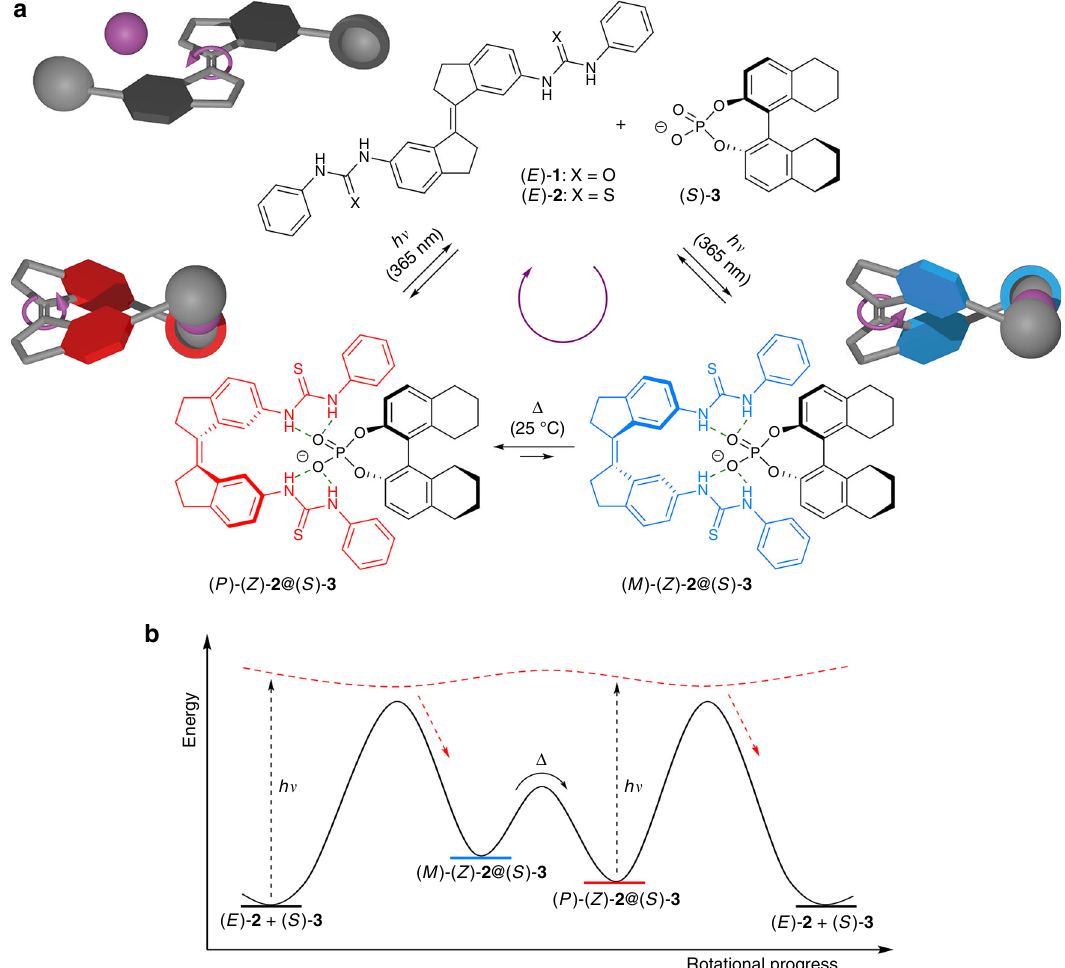
Fig. 1 Chiral substrate induced unidirectional rotation in a photoswitchable receptor. a Scheme of photochemical and thermal isomerization steps showing that when starting from the planar ( E )-isomer, e.g. bis-thiourea receptor ( E )- 2 , irradiation with light produces a racemic mixture of helical ( P )-( Z )- 2 and ( M )-( Z )- 2 . Binding of a chiral guest molecule to the receptor, e.g. phosphate ( S )- 3 favours formation of one of these helical ( Z )-isomers. As a consequence, the backward photochemical isomerisation process, affording the ( E )-isomer, takes place predominantly from the most favoured ( Z )-isomer, i.e. ( P )-( Z )- 2 @( S )- 3 resulting in a net unidirectional rotation. b Illustrative energy pro fi le describing a full rotation. Note that ( P )-( Z )- 2 and ( M )-( Z )- 2 are produced with equal probability and that only formation of the fi rst isomer gives rise to a rotation, while formation of the latter results in an